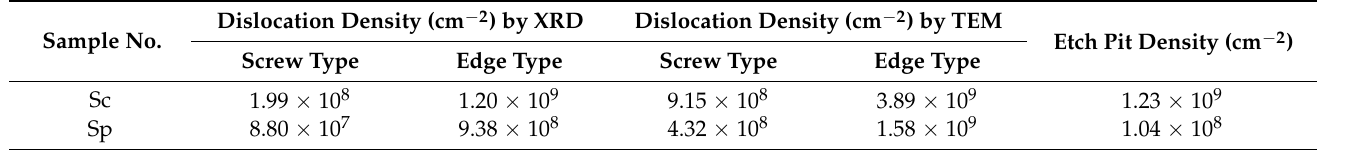
Figure 1. ( a ) The XRD patterns of AlN samples. ( b ) (0002) and ( c ) (101̅2) plane X-ray rocking curves of samples. Table 2. The dislocation density obtained by XRD and TEM, and the etch pit density of the AlN samples.